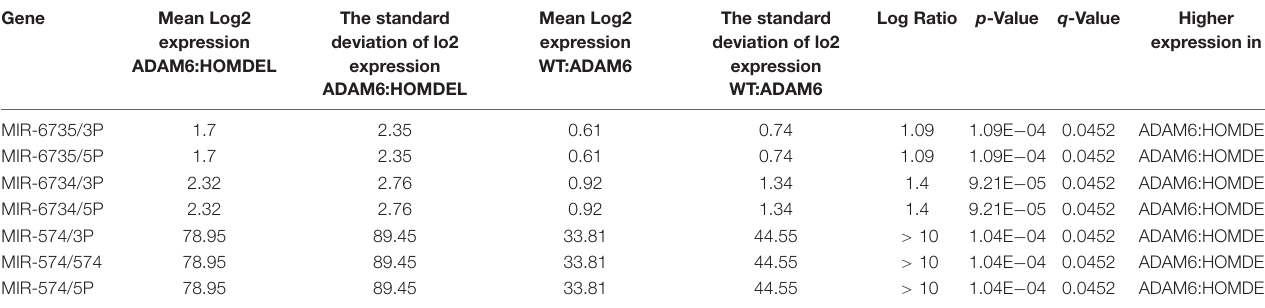
TABLE 6 | Specific microRNA changes between the ADAM6 HOM:DEL group and the rest of the patients. Gene Mean Log2